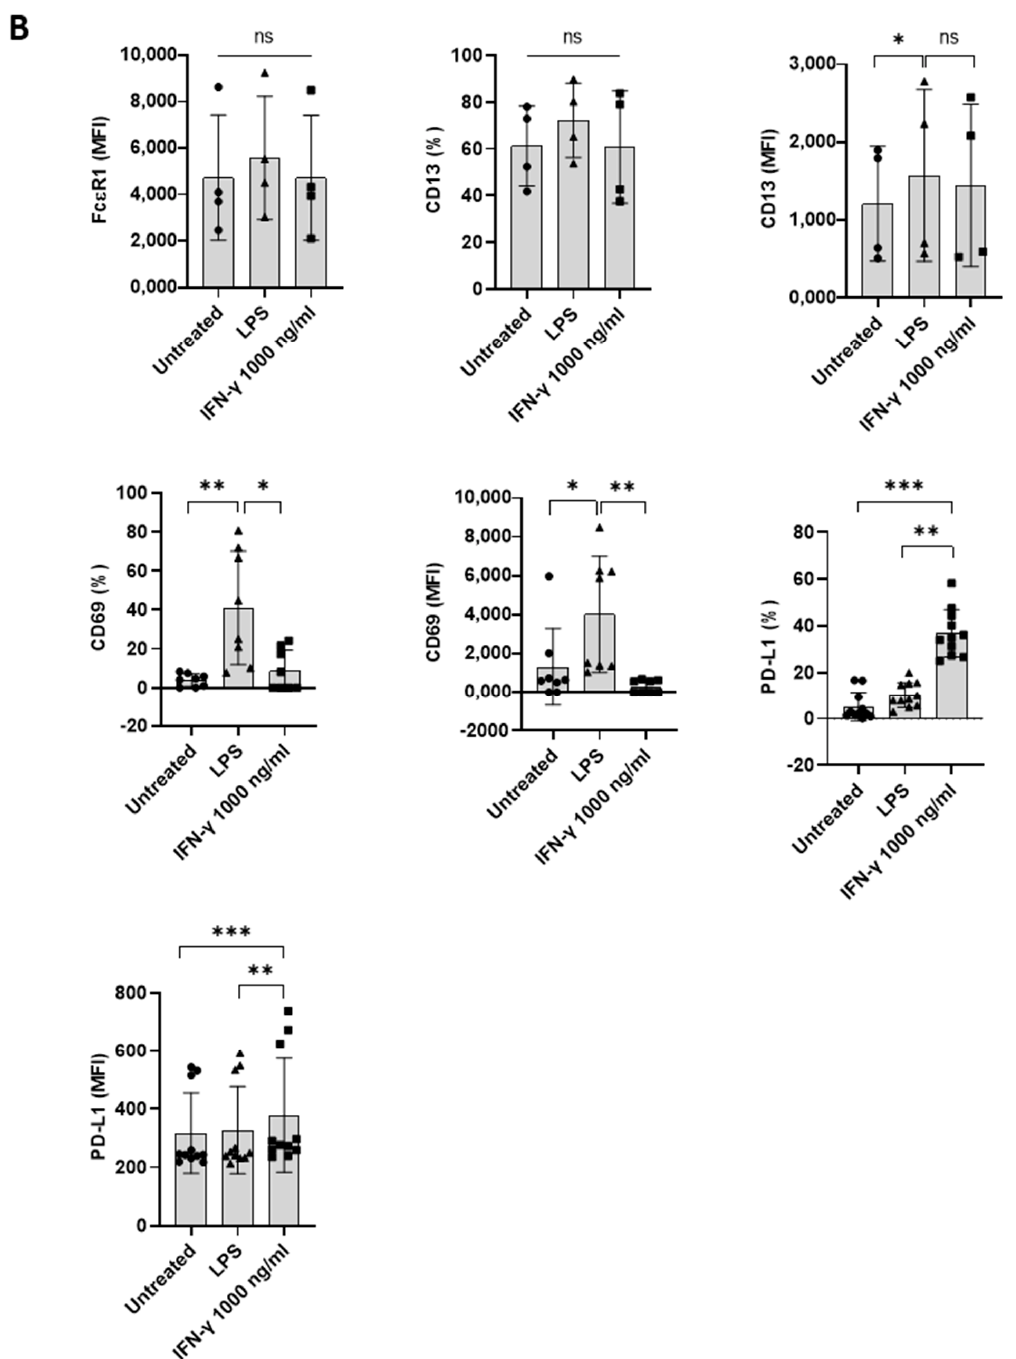
Figure 3. IFN- γ -induced PD-L1 expression in basophil is legible in PBMCs. Basophil-containing PBMCs (1 × 10 6 cells/mL/24-well plate) from the healthy donors were cultured with or without IFN- γ at 1000 ng/mL or LPS at 100 ng/mL for 24 h. After incubation, cells’ phenotype was evaluated by flow cytometry. ( A ) Gating strategy and representative histogram overlays are displaying the expression pattern of Fc ε R1, CD107a, CD13, CD69, and PD-L1 on the basophils. ( B ) Expression of Fc ε R1, CD13, CD69, and PD-L1 on the basophils (% positive cells and median fluorescence intensities (MFI), mean ± SD; n = 4–11 independent donors from three independent experiments). ns, not significant, * p < 0.05, ** p < 0.01, *** p < 0.001, one-way ANOVA Friedman test with Dunn’s multiple comparisons post-test.